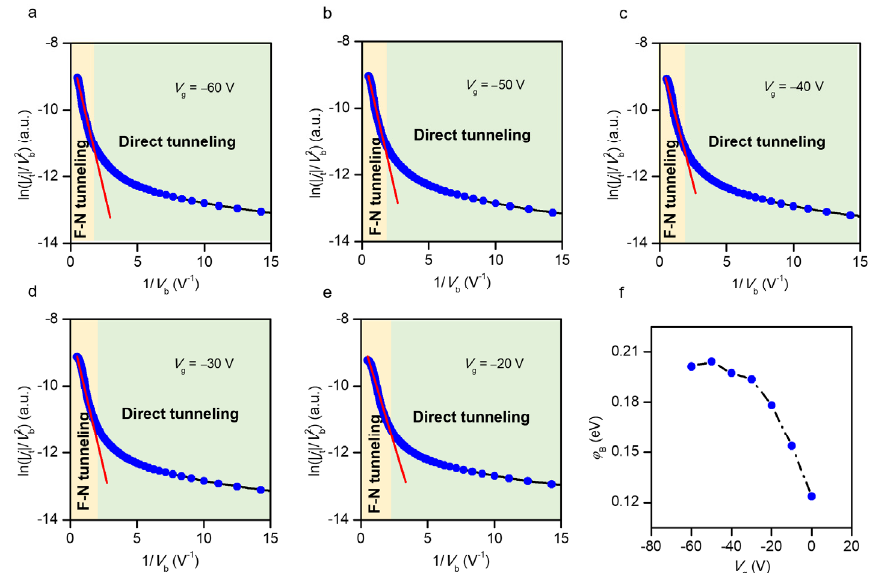
Figure 4. FN tunneling and direct tunneling in GWMHs devices. ( a – e ) ln(| j t |/ V b 2 ) versus 1/ V b curves of the GWMHs devices at different values of V g . The linear behavior with FN tunneling is observed at a higher bias voltage (yellow region with red dashed line), and direct tunneling is observed at a lower bias voltage (green region). ( f ) The variation in the barrier height as a function of V g .